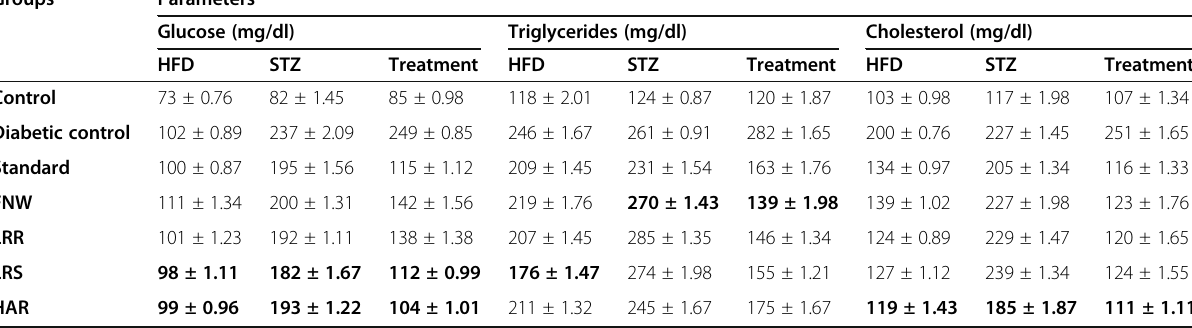
Table 7 Anti-diabetic activity of HFD with streptozotocin-induced rats